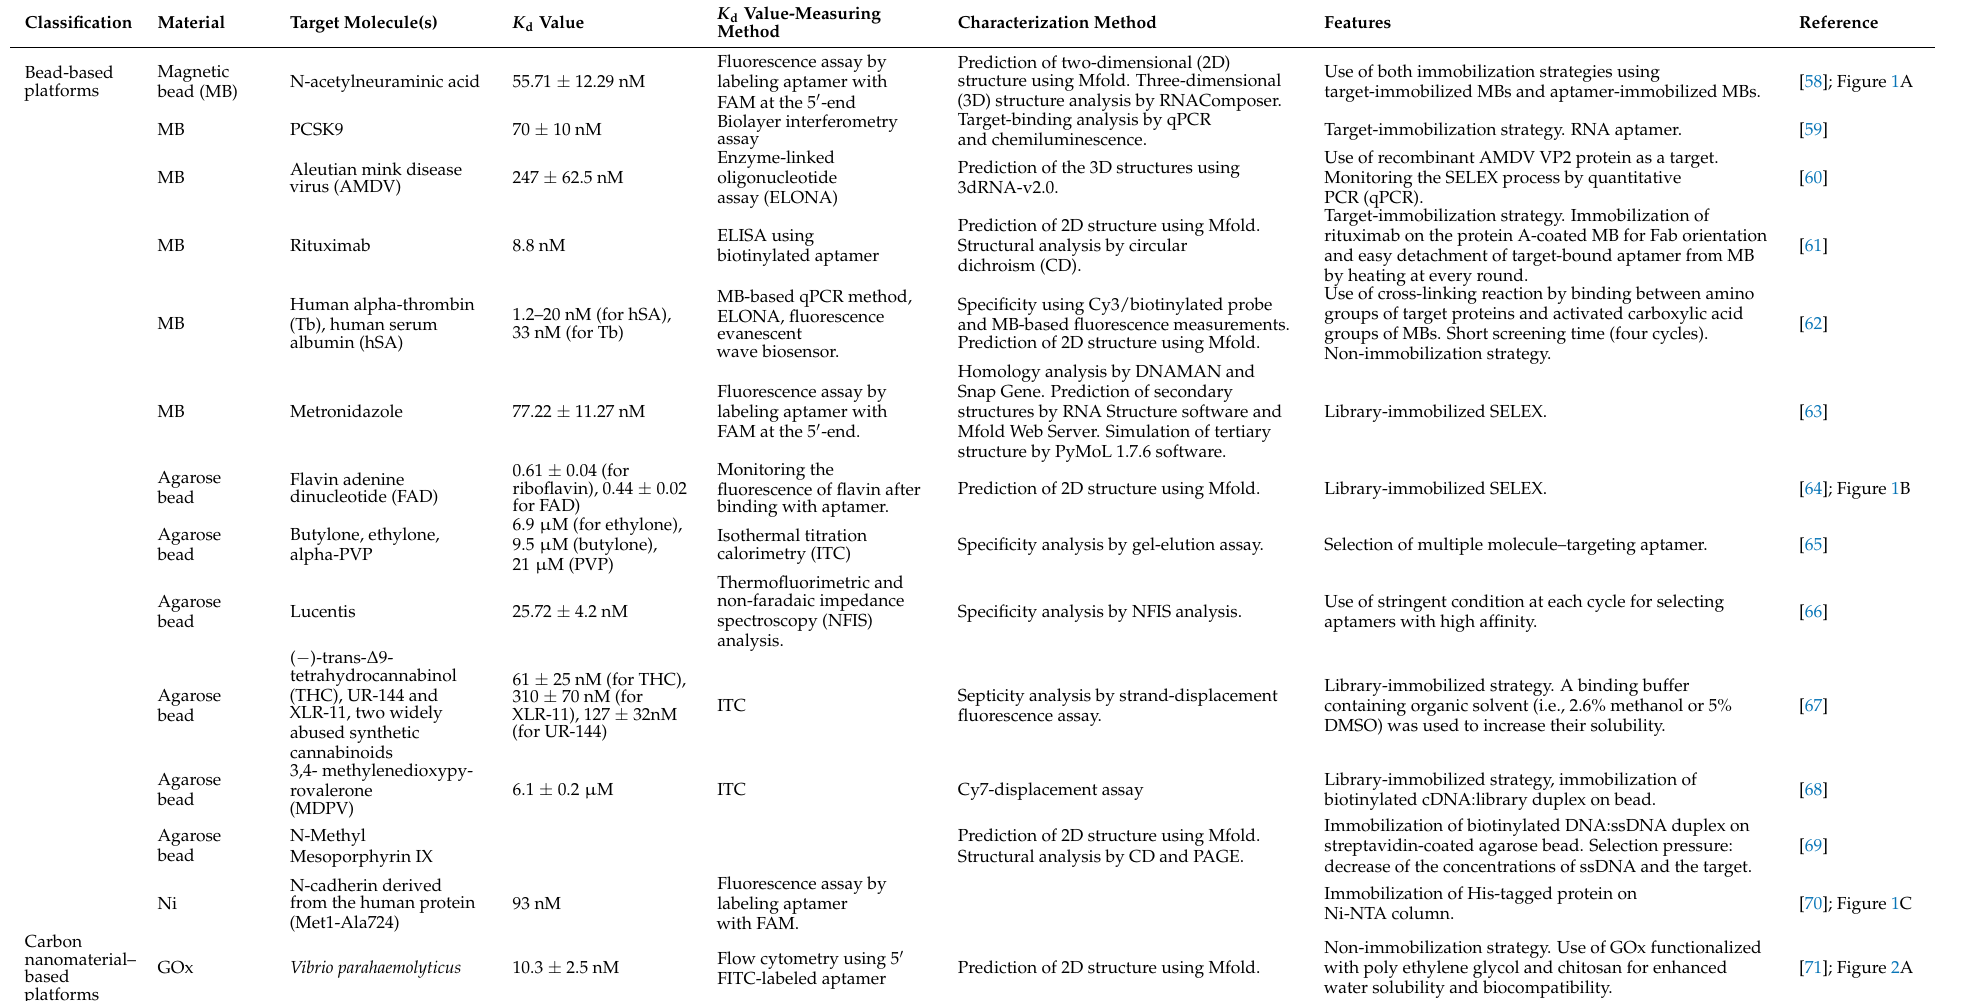
Table 2. Examples of micro/nanomaterial-based selection of aptamers for various target molecules.